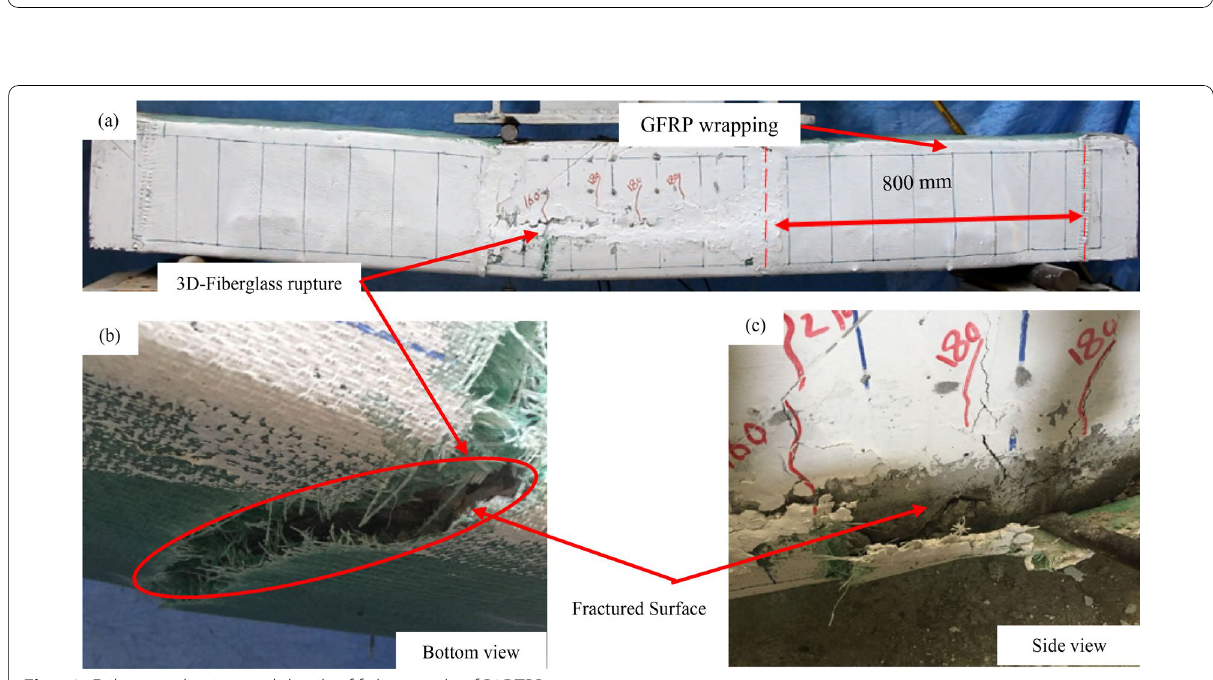
Fig. 18 Failure mechanism and details of failure mode of R3DTRB specimen.